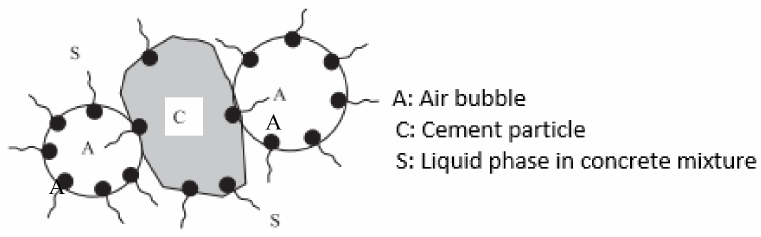
Figure 3. Interaction between air bubbles and cement particles